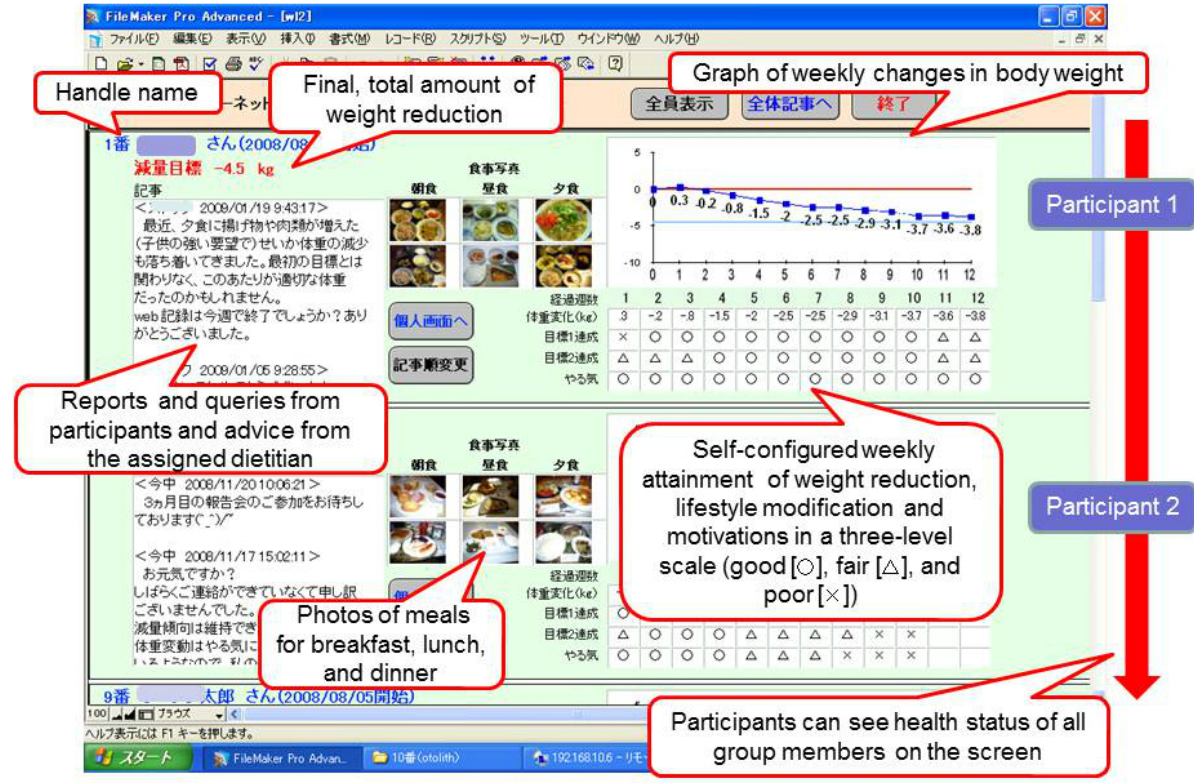
Figure 1. Screen view of the Web-based self-disclosure (WSHS) health support